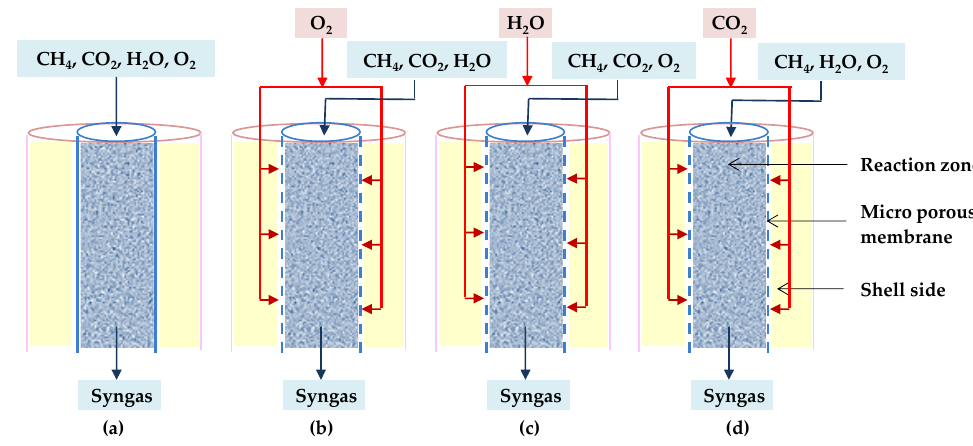
Figure 18. Diagrams of ( a ) TRM, ( b ) O-TRM, ( c ) H-TRM, and ( d ) C-TRM [88].